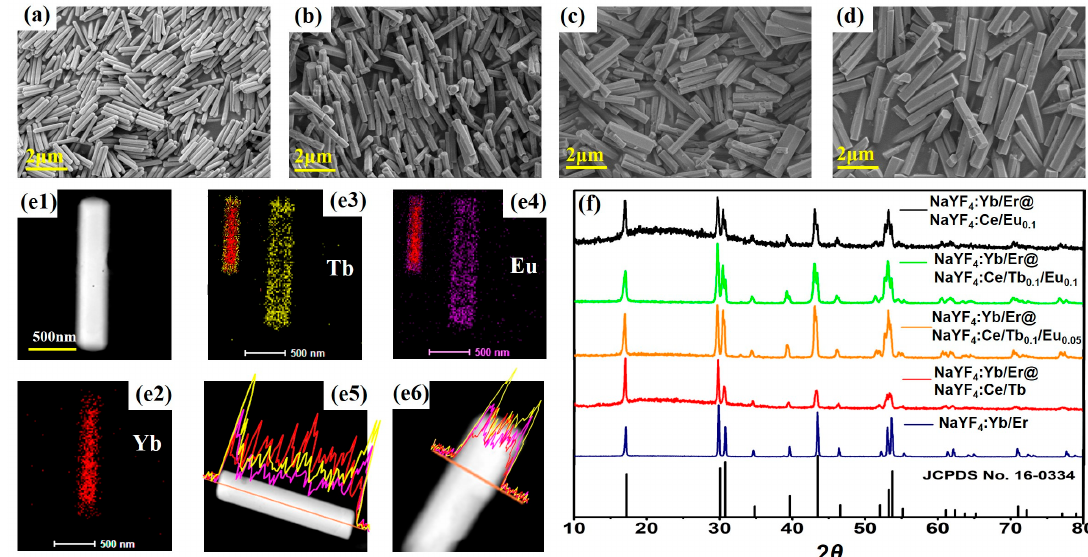
Figure 1. ( a – d ) SEM imaging of the samples, NaYF 4 :Yb/Er, NaYF 4 :Yb/Er@NaYF 4 :Ce/Tb 0.1 , NaYF 4 :Yb/Er@NaYF 4 :Ce/Tb 0.1 /Eu 0.05 , NaYF 4 :Yb/Er@NaYF 4 :Ce /Eu 0.1 microrods. ( e1 ) The STEM image of the NaYF 4 :Yb/Er@NaYF 4 :Ce/Tb 0.1 /Eu 0.05 microrods. ( e2 – e4 ) are the element mappings of Yb, Tb and Eu in a single NaYF 4 :Yb/Er@NaYF 4 :Ce/Tb 0.1 /Eu 0.05 microrod, respectively. The insets in Figure ( e3 , e4 ) are the element composition images of Yb-Tb and Yb-Eu, respectively. ( e5 , e6 ) are line scans of the element distributions of Yb, Tb and Eu in the single microrod along the axial direction and radial direction, respectively. The red, yellow, and purple lines represent the Yb, Tb and Eu elements, respectively. ( f ) XRD patterns of the samples.